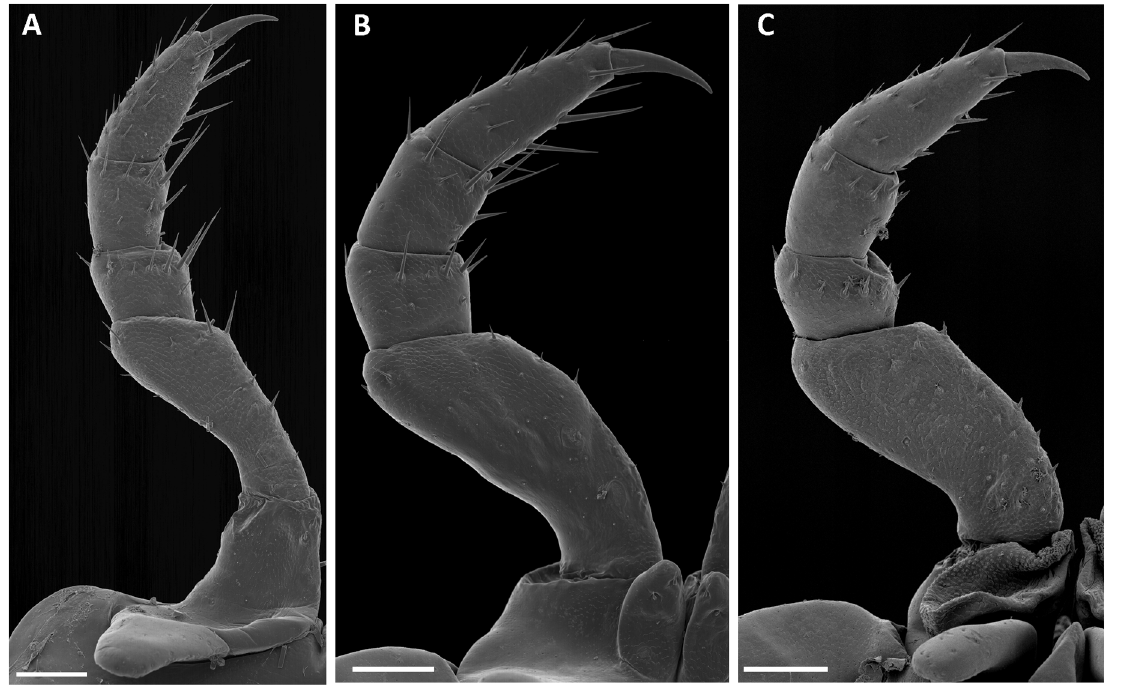
Fig. 8. Aquattuor spp., males, left leg of first pair. A . A. stereosathe Enghoff, 2015, paratype, ♂ (NHMD 621650): setae same length as in normal walking legs. B . A. longipala Enghoff, 2015, specimen from Udzungwa Mts National Park, Mito Mitatu (NHMD 621642): setae of femur shortened. C . A. mollilobus sp. nov., paratype, ♂ (NHMD 621646): all setae shortened. Scale bars = 0.1